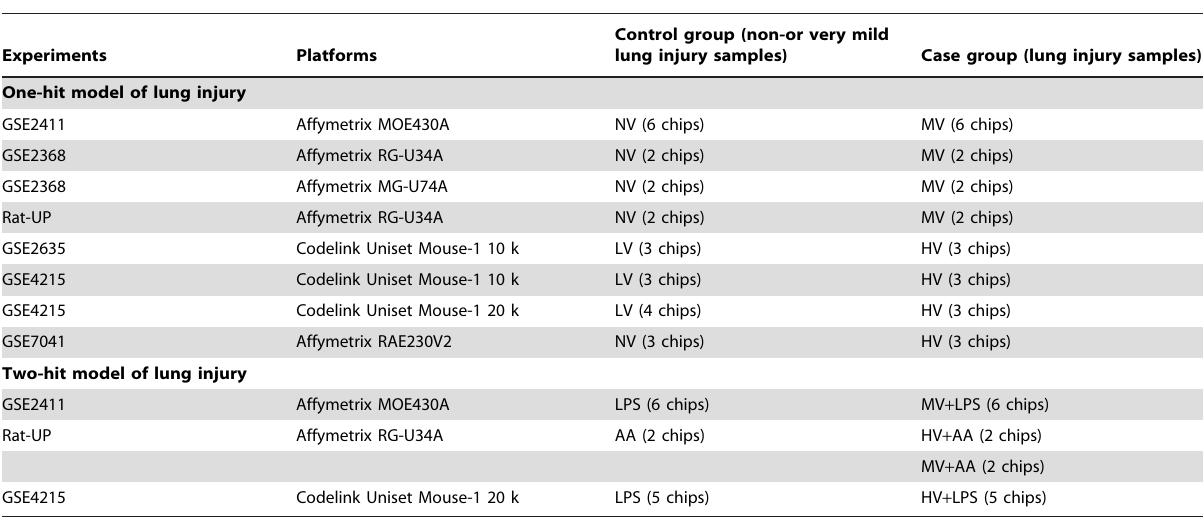
Table 2. Group assignment of microarray